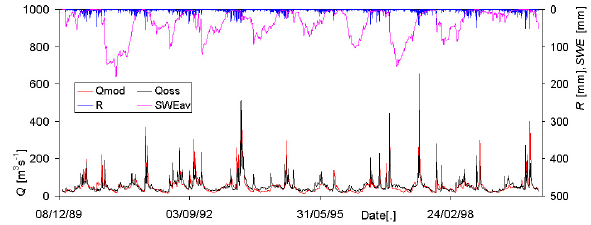
Fig. 4. Oglio at Sarnico. Model calibration. Mean daily discharges during 1990–1999. Average Rainfall and snowpack SWE reported.